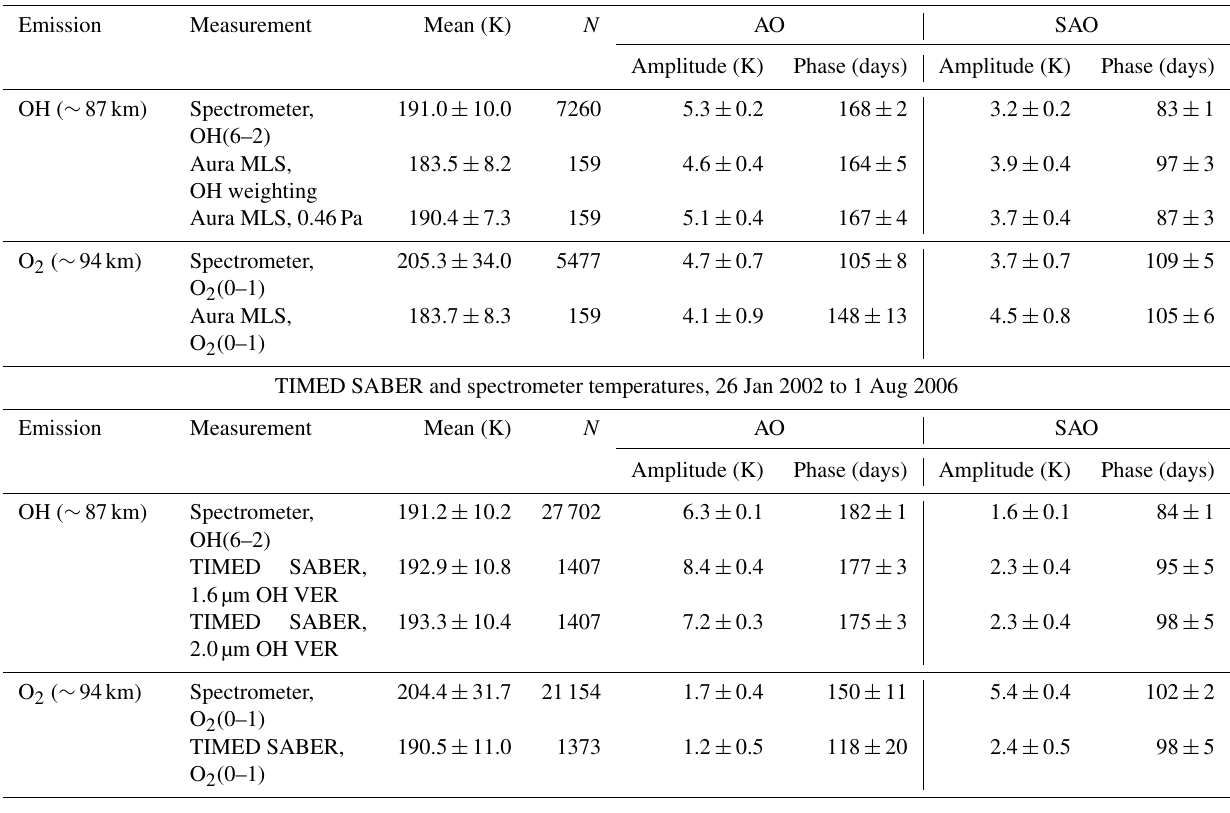
Table 2. Comparison between coincident Aura MLS and TIMED SABER and spectrometer temperatures. The Aura MLS results are for 8 August 2004 to 1 August 2006 and the TIMED SABER results for 26 January 2002 to 1 August 2006. N is the number of points in each sample. Note that the Aura MLS O 2 weighting is marginal with respect to the lowest recommended pressure (0.001hPa). See text for further